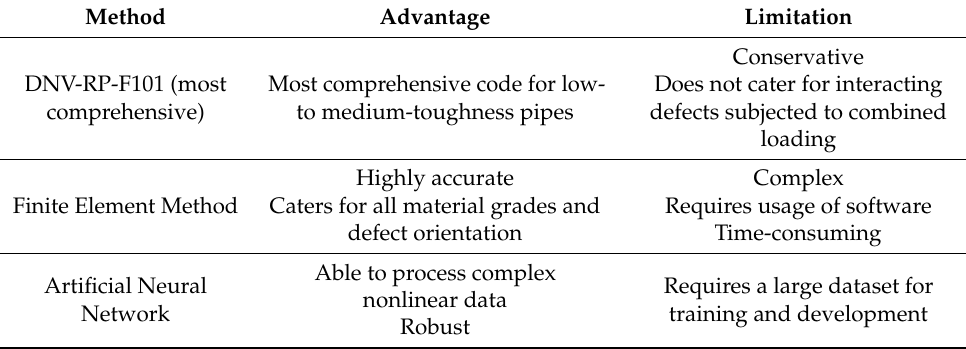
Table 2. Summary of common corrosion assessment